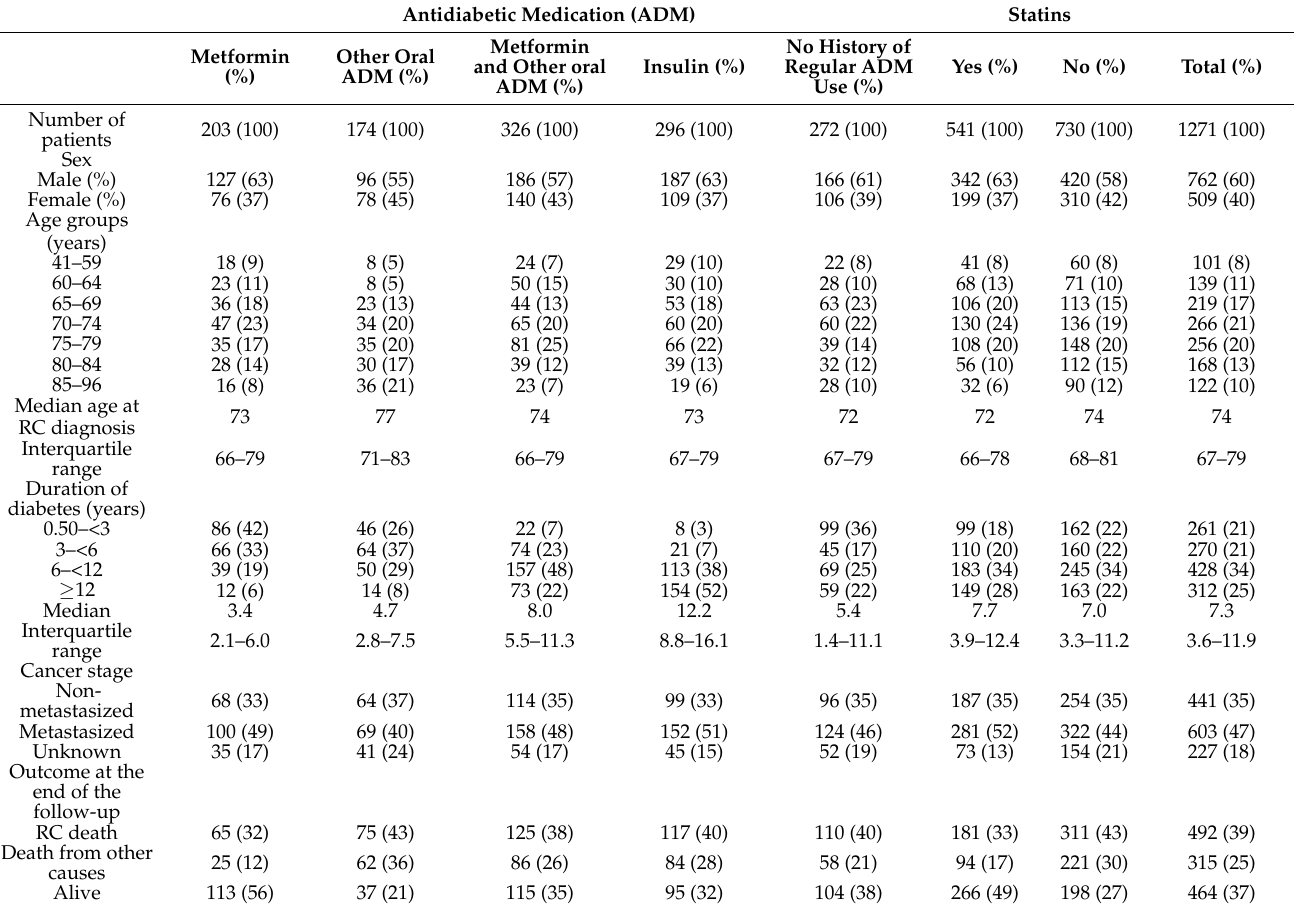
Table 1. Characteristics of the study cohort in different pre-diagnostic antidiabetic medication (ADM) groups and by statin